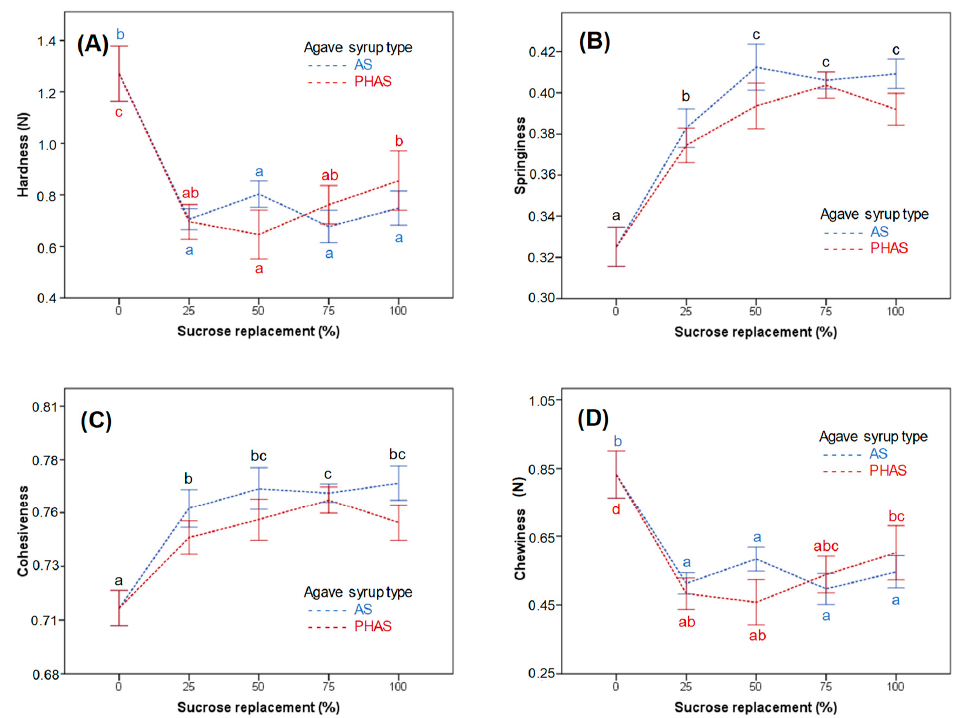
Figure 5. The impact of sucrose replacement by AS and PHAS on the textural profile analysis of muffins: ( A ) hardness, ( B ) springiness, ( C ) cohesiveness, and ( D ) chewiness. The different subscript letters of the same color represent Tukey’s homogeneous groups, with significant ( p < 0.05) differences between different sucrose replacement levels for AS (blue letters), PHAS (red letters), or for both types of agave syrup when there was no interaction between sucrose replacement and agave syrup type (black letters).